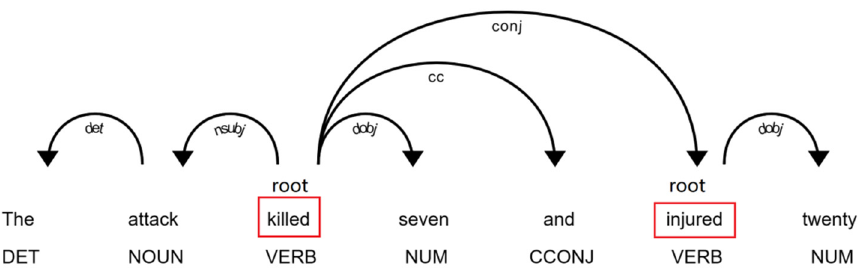
Figure 2. An example of syntactic dependency parsing.